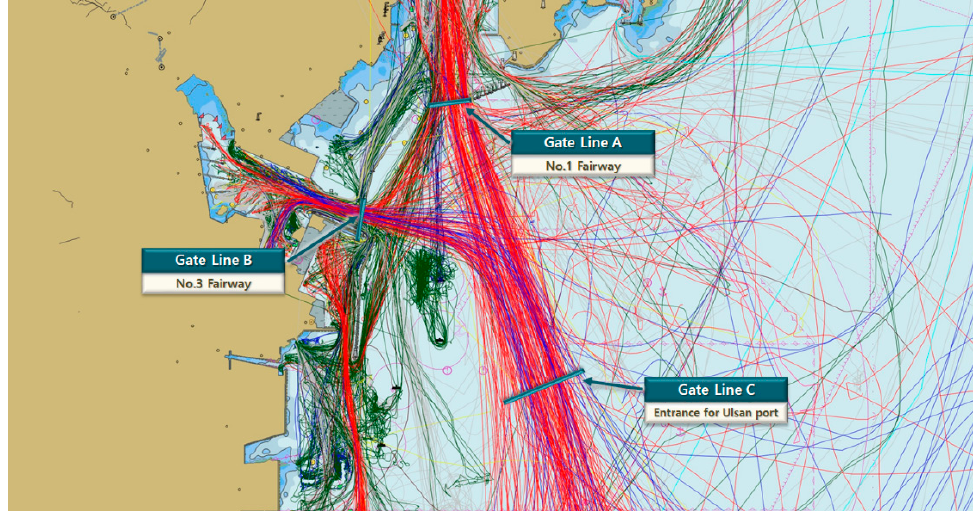
Figure 2. AIS Data visualization of target sea area.